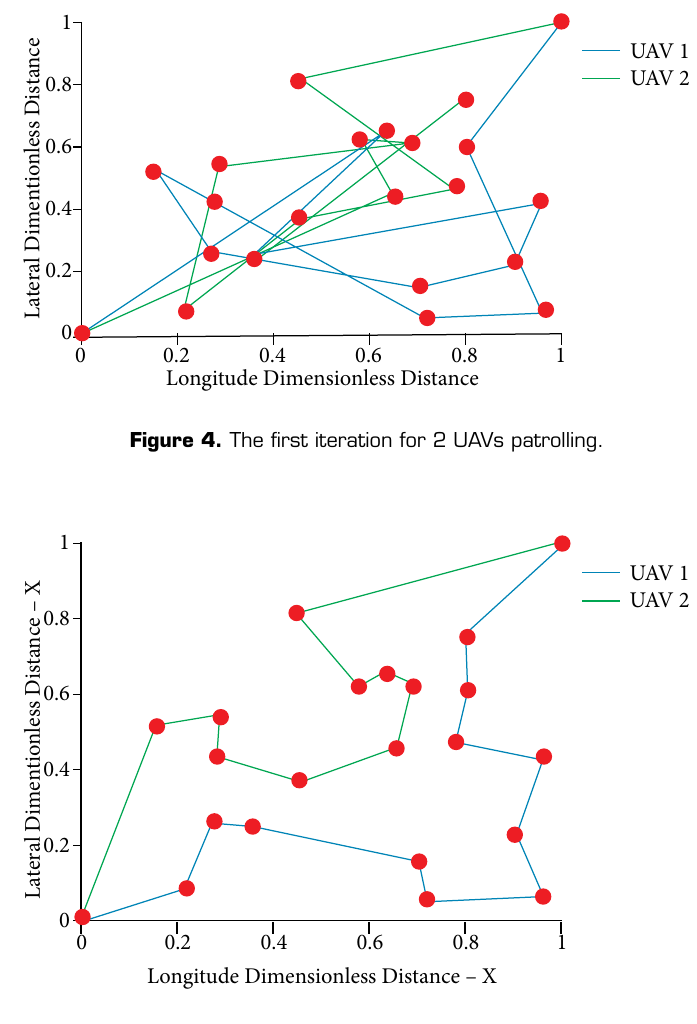
Figure 5. The optimal path for 2 UAVs patrolling, the average traveling distance is